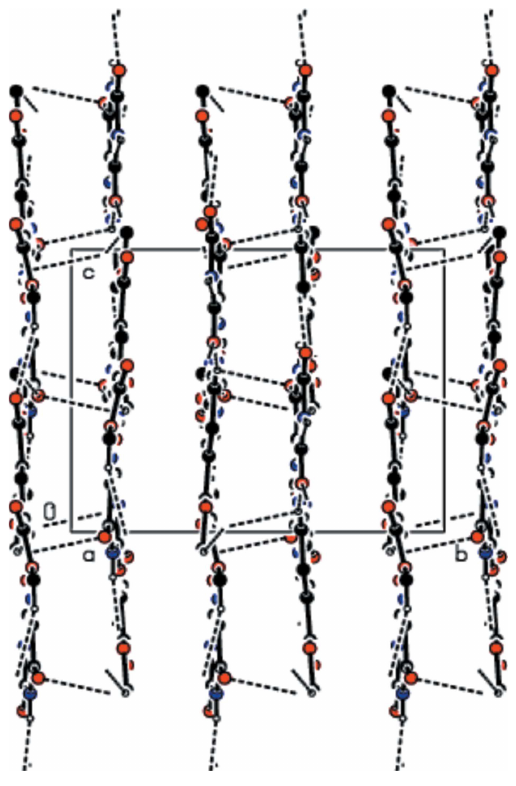
Figure 2 A view down the a axis showing the intermolecular contacts forming the layered structure.